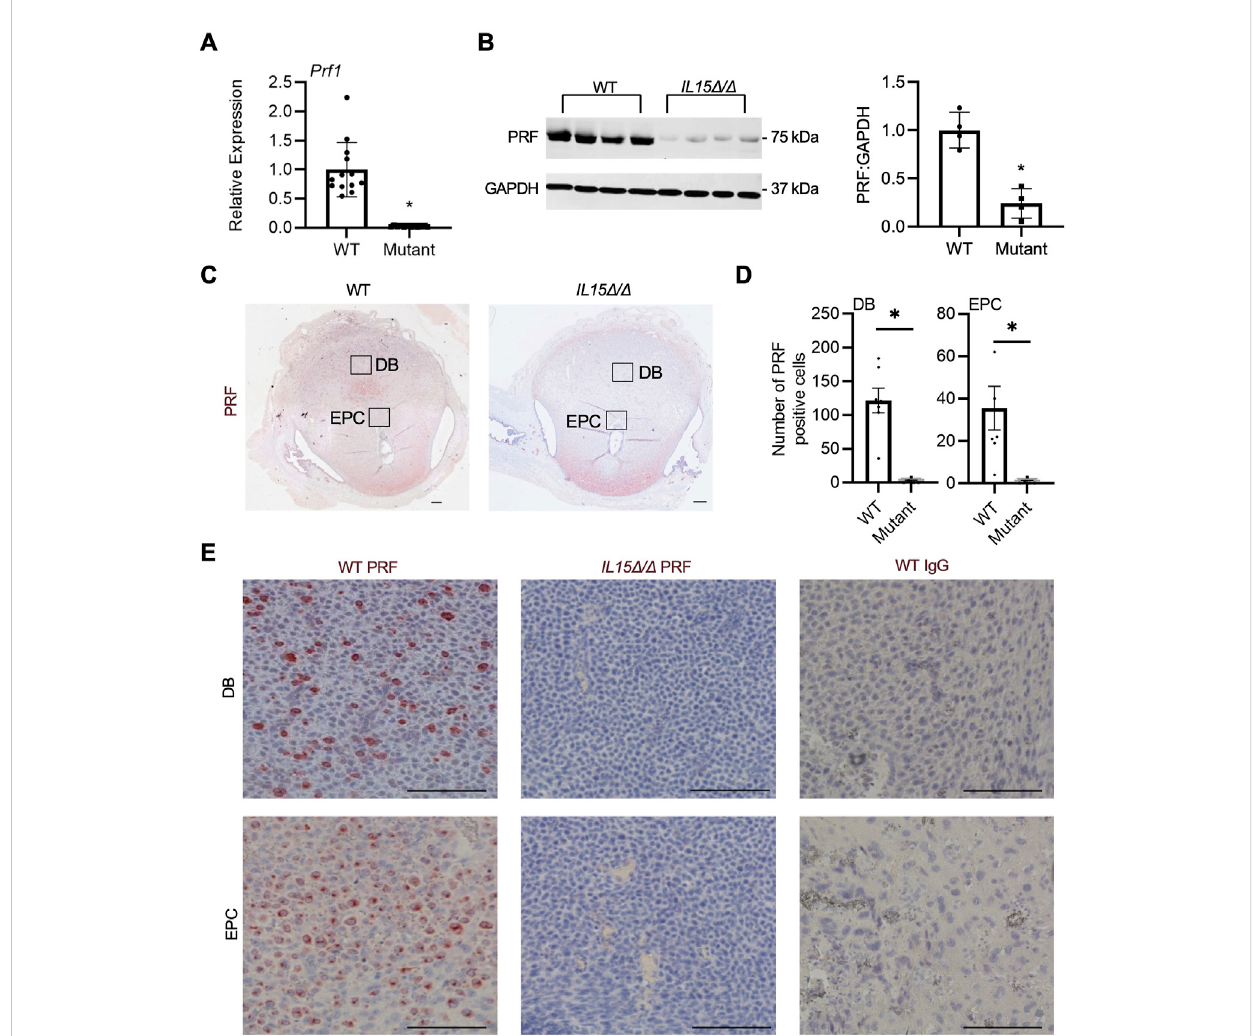
FIGURE 2 IL15 Δ / Δ rats are devoid of PRF-containing cells in the uterus on GD 9.5. (A) Quantitative RT-PCR comparing Prf1 levels between implantation sites from WT and IL15 Δ / Δ (mutant) rats ( N ≥ 13 implantation sites from at least 5 dams per group). (B) Western blot showing decreased PRF levels in implantationsitesfrom IL15 Δ / Δ ratscomparedtoimplantationsitesfromWTrats.GAPDHwasusedasaloadingcontrol.Thehistogramontherightshows results from densitometric analysis comparing PRF levels relative to GAPDH ( N = 4 per group). (C) Images of PRF immunohistochemistry in WT versusIL15 Δ / Δ implantationsites.Scalebar,250 µm.Theboxesshowtheapproximatelocationofhighmagni fi cationimages in (E) forthedeciduabasalis (DB) and near the ectoplacental cone (EPC). (D) Quanti fi cation of PRF-positive cells in WT and IL15 Δ / Δ implantation sites ( N ≥ 5 implantation sites from differentdams per group) inthe DB and near the EPC. (E) Representativehigh magni fi cation images showing PRF localization in theDB and near theEPC on GD 9.5. Please note the lack of PRF detection in IL15 Δ / Δ decidua. The right panels show images captured following immunohistochemistry of WT implantationsitesusinganon-speci fi crabbitIgGinplaceofPRF.Scalebar,50 µm.Panel (A) wasanalyzedusingalinearmixedmodelfollowedbyTukey ’